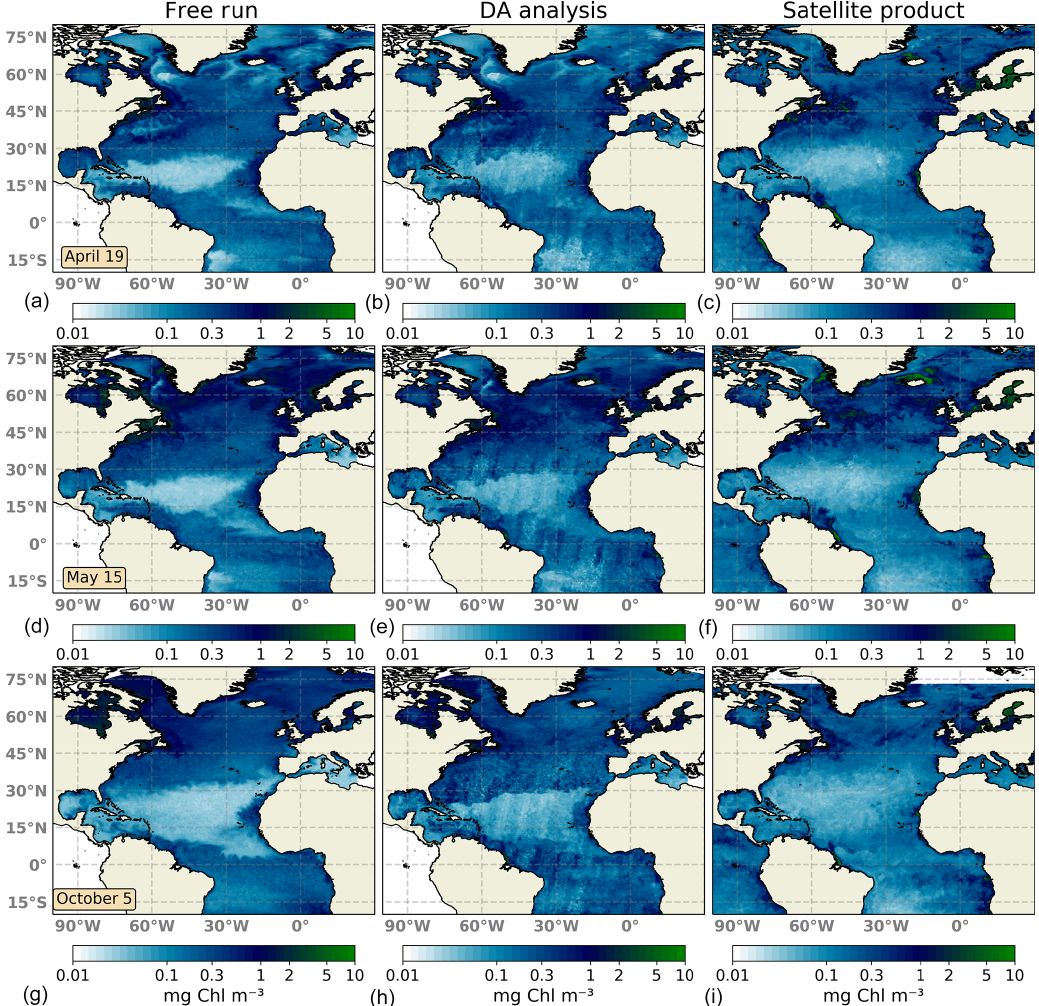
Figure 2. Surface maps of Chl a (mgChlm − 3 ) for 19 April 2005 (a, b, c) , 15 May 2005 (d, e, f) , and 5 October 2005 (g, h, i) . The ensemble median of the non-assimilated free-run experiment (a, d, g) , the analysis ensemble median of the assimilation experiment (b, e, h) , and merging daily surface Chl a fields obtained from the Global Ocean Satellite Observations (c, f, i) are